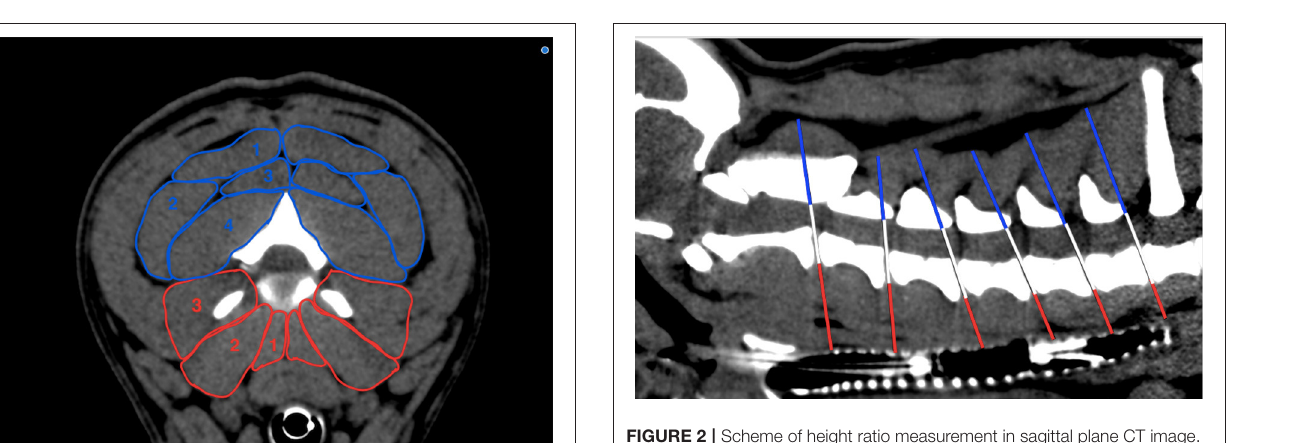
FIGURE 2 | Scheme of height ratio measurement in sagittal plane CT image. White line: level of each intervertebral disk space of the cervical spine; red line: distance v; blue line: distance